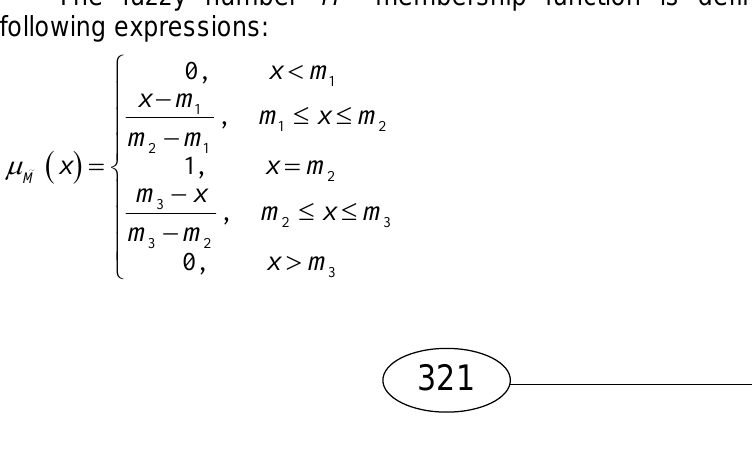
Figure 2 – Triangular fuzzy number M Рис. 2 – Треугольное фаззи-число M Слика 2 – Троугласти fuzzy број